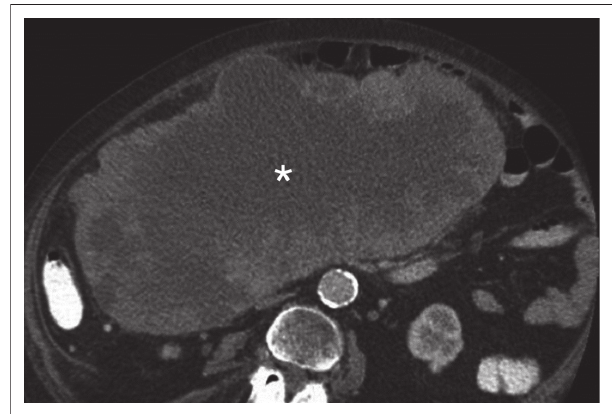
FIGURE 2: Axial computed tomography images of the mass, showing a large (20 cm × 27 cm ×16 cm), lobulated mass with heterogeneous contrast uptake, lack of calcifications and central necrosis, originating from the mesentery (asterisk). Evident mass effect but no invasion of the adjacent small bowel.